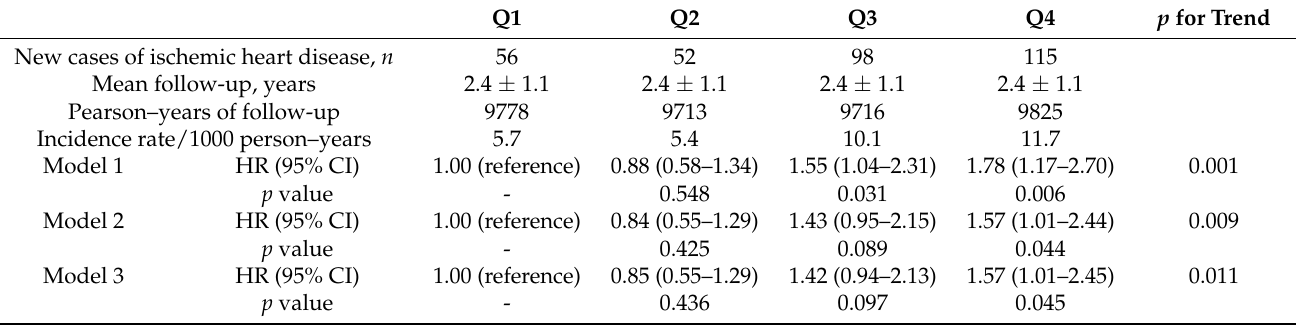
Table 2. Hazard ratios (95% confidence intervals) for incident ischemic heart